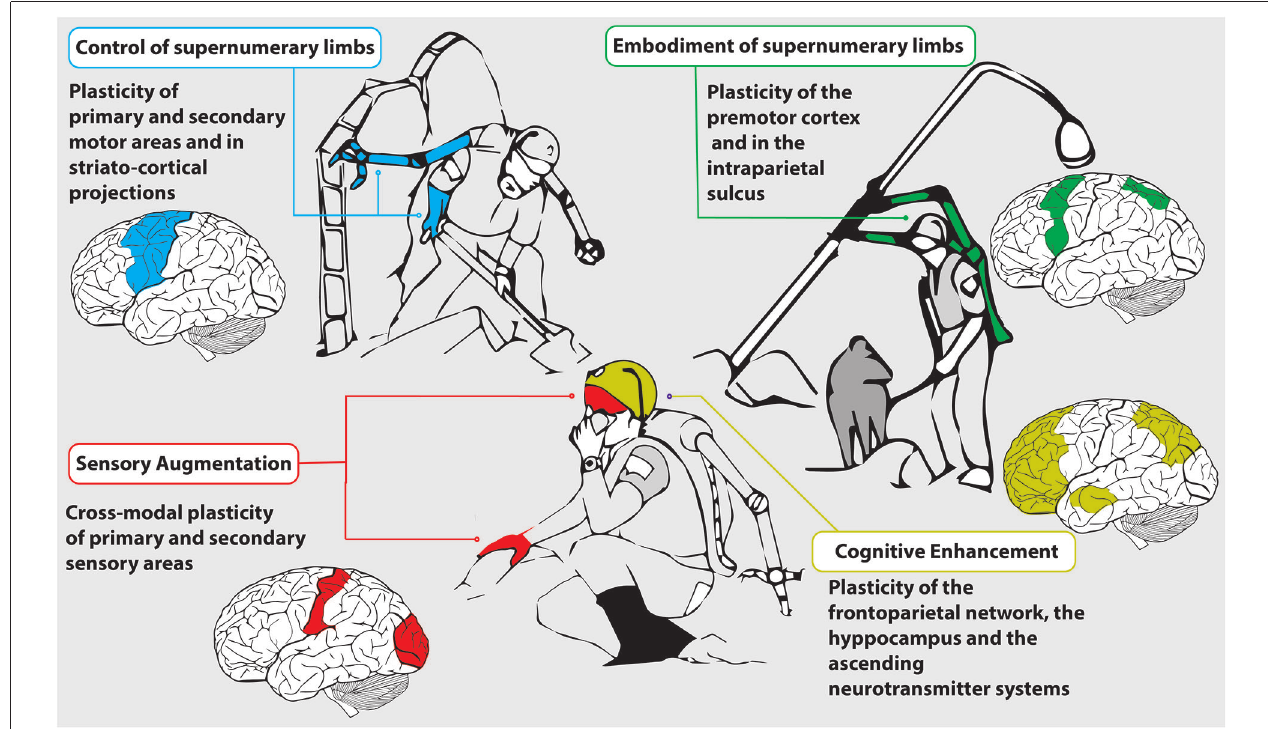
sensorimotor areas and on the facilitation of striato-cortical projection, their embodiment in changes especially taking place in the premotor cortex and in the intraparietal sulcus. Sensory augmentation is enabled by cross-modal plasticity of sensory areas, while cognitive enhancement has in the neural plasticity of the frontoparietal network, of the hippocampus and in the facilitation of the ascending neurotransmitter system its neurobiological